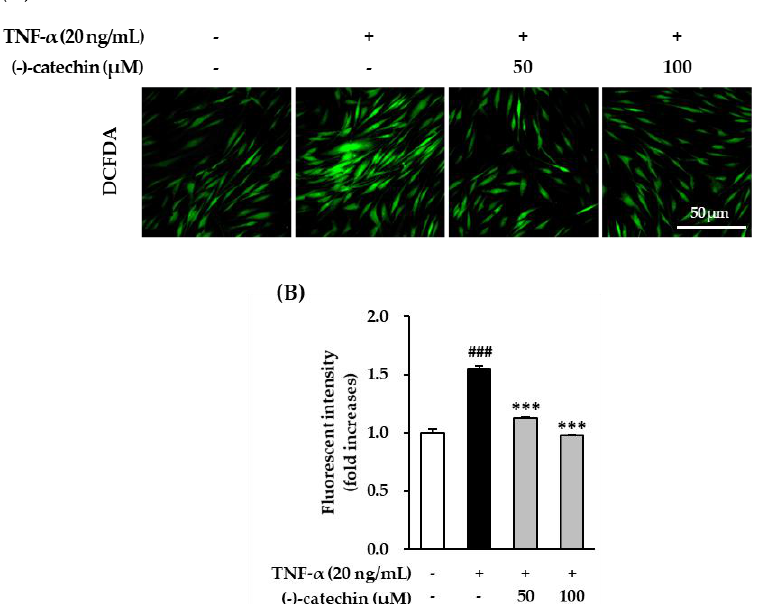
Figure 3. Inhibitory effect of (-)-catechin on intracellular reactive oxygen species (ROS) production in tumor necrosis factor- α (TNF- α )-stimulated normal human dermal fibroblasts (NHDFs). The cells were seeded at a density of 1 × 10 4 in a 96-well plate and incubated for 24 h. The cells were continuously starved in serum-free Dulbecco’s Modified Eagle Medium (DMEM) for 24 h. Thereafter, the cells were treated with 50 and 100 µ M (-)-catechin for 1 h, and then with 20 ng / mL TNF- α and 10 µ M dichlorofluorescin diacetate (DCFDA) for 15 min. ( A ) Fluorescent images were captured by fluorescence microscopy (scale bar = 50 µ m). ( B ) The graph presents the fold-increase in fluorescent intensity compared with the untreated group. The data are presented as mean ± SEM (N = 3). ### p < 0.001 compared with the untreated group; *** p < 0.001 compared with the TNF- α -treated group.